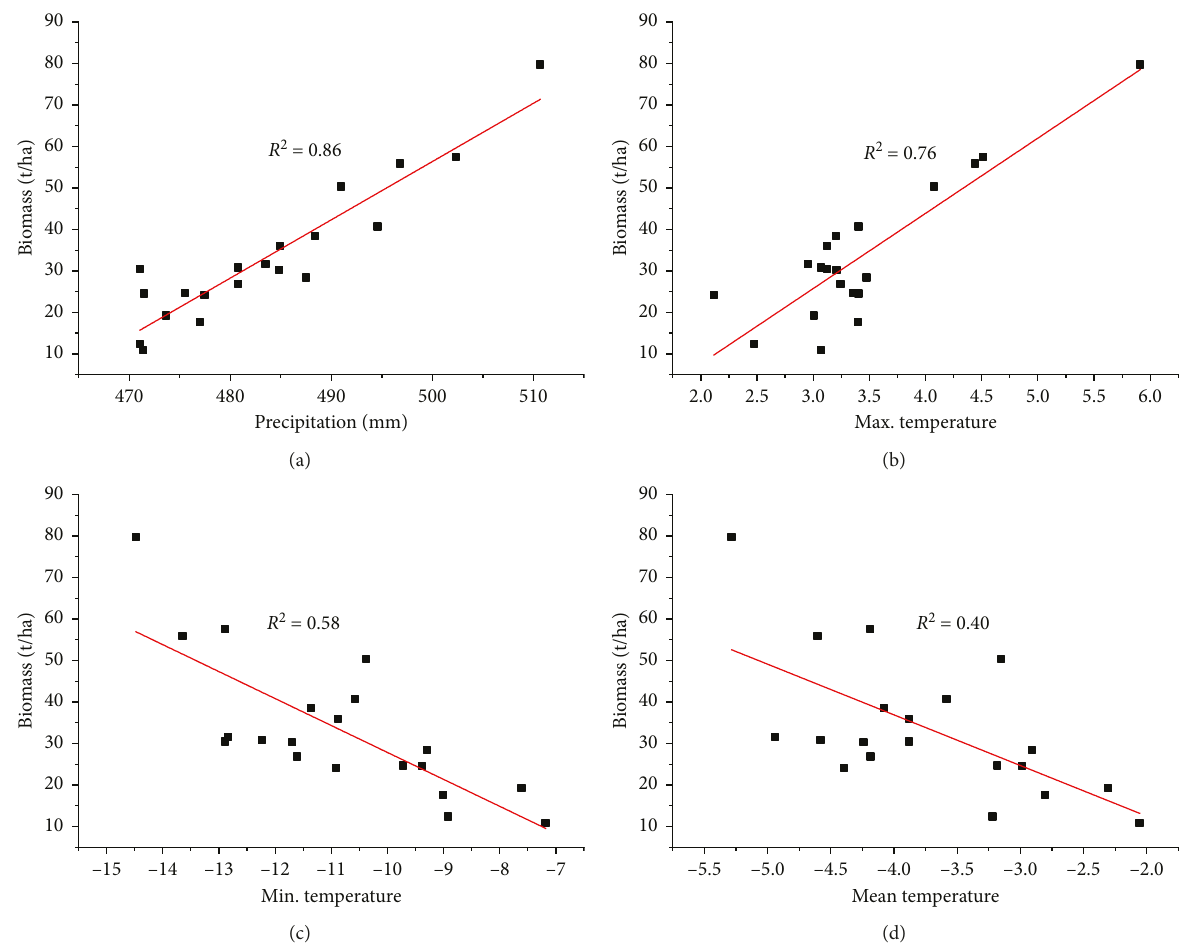
Figure 3: Relationship between Larix gmelinii stem biomass (SB) with > 470mm (PPT) along climatic gradients from 1950 to 2016: (a) annual precipitation; (b) annual maximum temperature; (c) annual minimum temperature; (d) annual mean temperature.